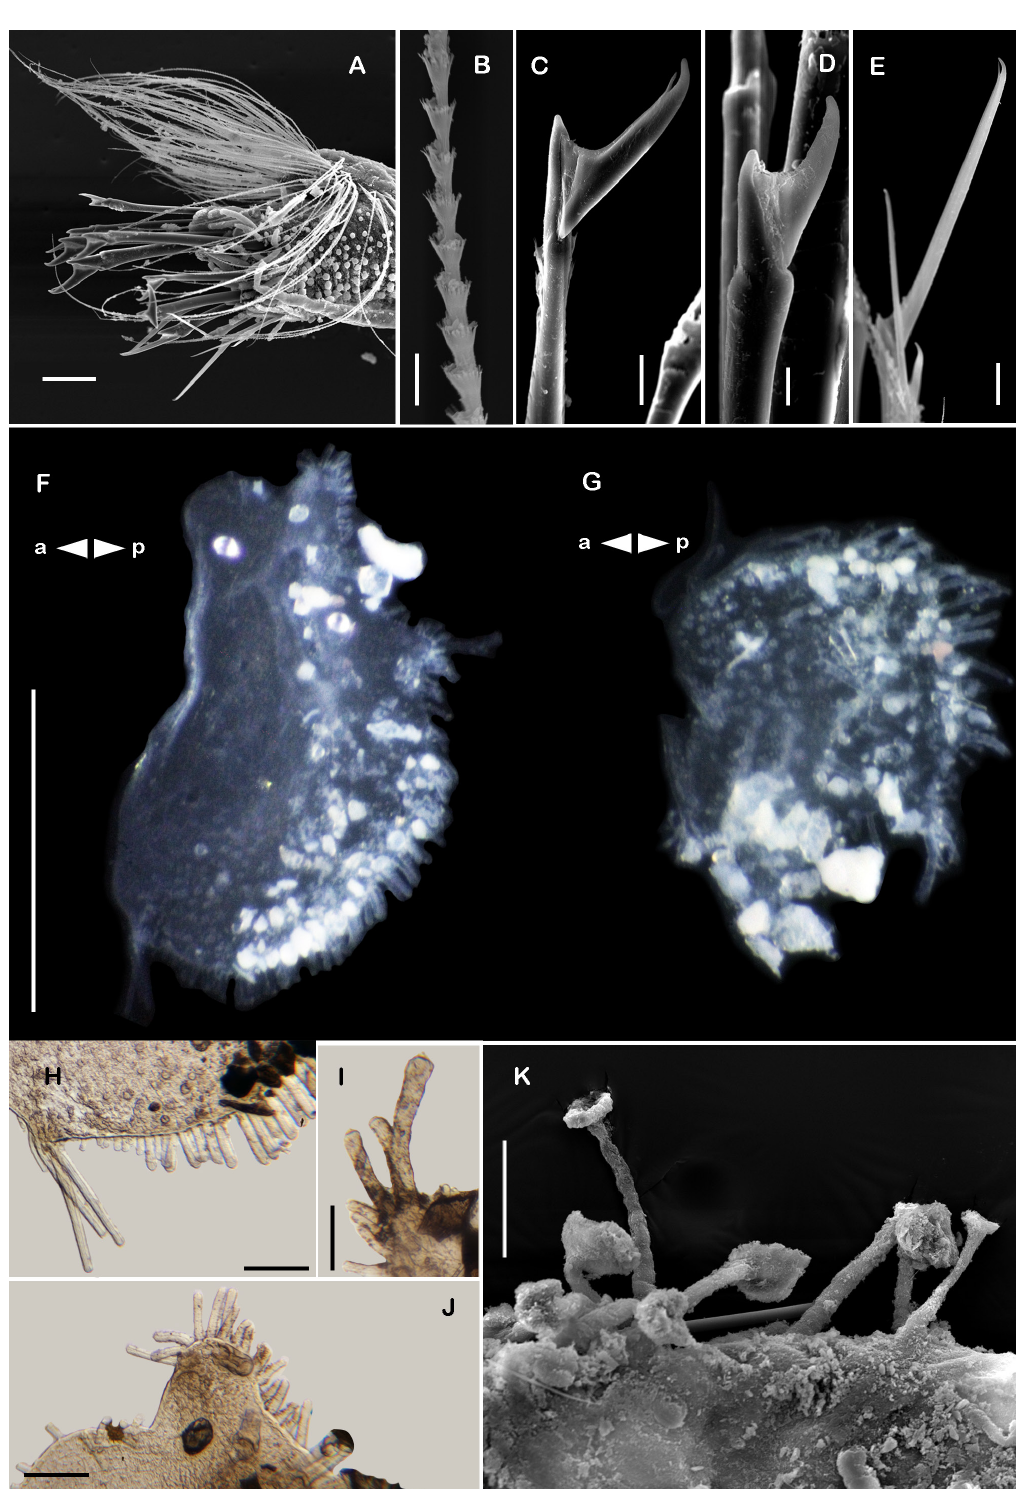
Fig. 4. Dayipsammolyce paulayi sp. nov., holotype (UF 2777). A–E, K. SEM micrographs. A . Right parapodium from segment 26. B . Notochaeta from same. C . Unit B. D . Unit C. E . Unit D. F . Second left elytron. G . Right posterior elytron. H . Detail of distal margin of F. I . Posterior process from G. J . Posterior process from F. K . Marginal papillae. Abbreviations: a = anterior; p = posterior. Scale bars: A, H–J = 100 μm; B = 5 μm; C, E = 20 μm; D = 10 μm; F–G = 500 μm; K = 50